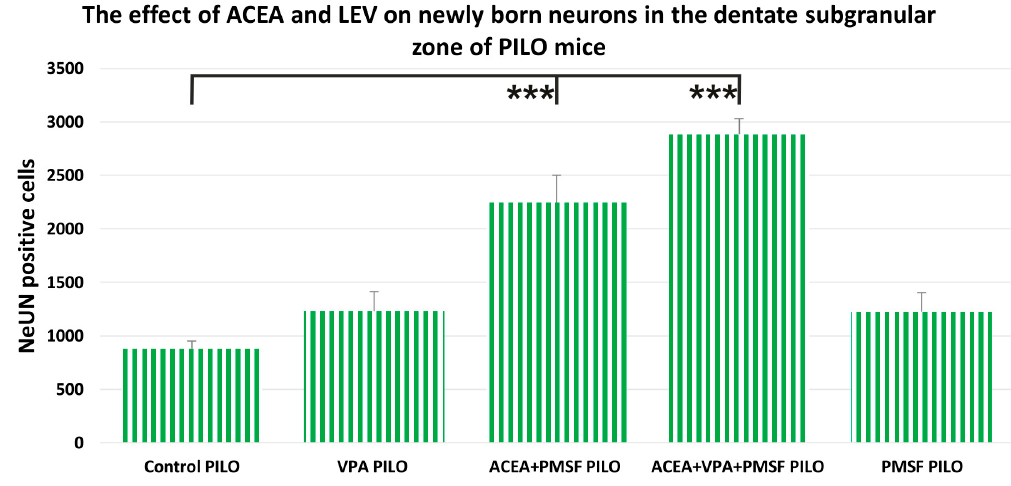
Figure 3. The effects of synthetic cannabinoid arachidonyl-2 ′ -chloroethylamide (ACEA) and valproic acid (VPA) on newly born neurons in the dentate subgranular zone of PILO mice. The numbers of cells represent an estimate of the total number of positively labeled cells in the subgranular zone in both hemispheres. The results were analyzed using one-way analysis of variance (ANOVA) followed by the Dunnte’s test for multiple comparisons. Each bar represents the mean for five or six mice; error bars are S.E.M. (*** p < 0.001).